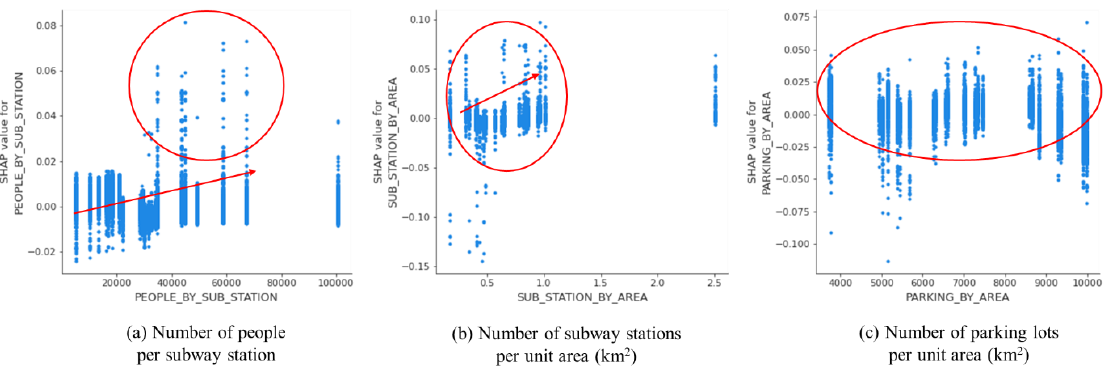
Figure 11. Dependence plots for features related to subways and parking facilities.